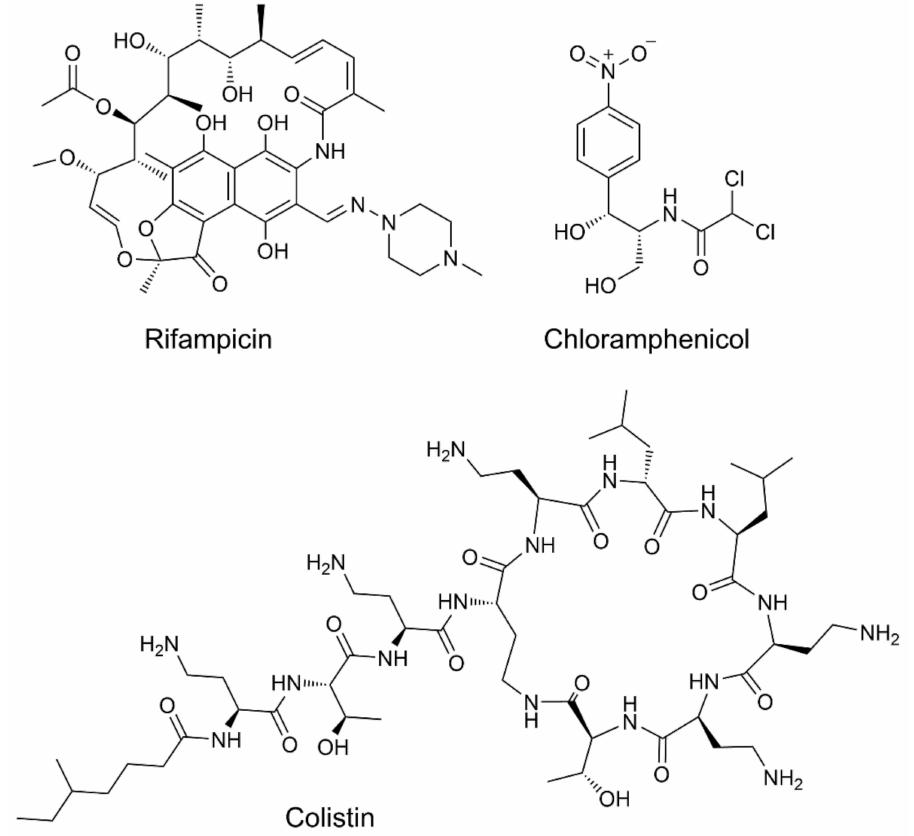
Figure 2. Structural formulas for rifampicin, chloramphenicol and